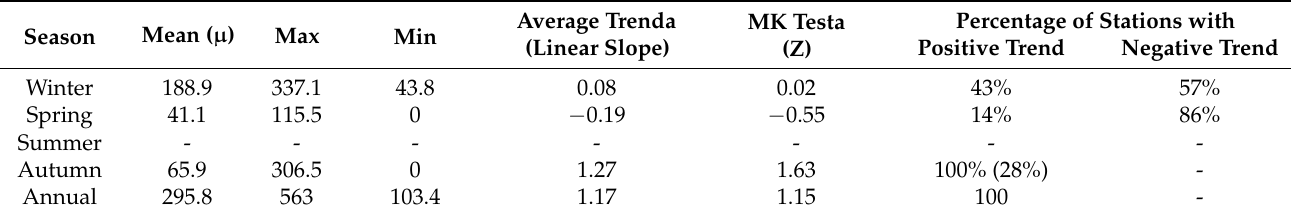
Figure 2. The average seasonal and annual rainfall trends in Gaza between 1974 and 2016. The straight line represents the linear trend. Table 3. The average long-term (1974–2016) seasonal and annual precipitation trends in Gaza based on linear regression and Mann Kendall